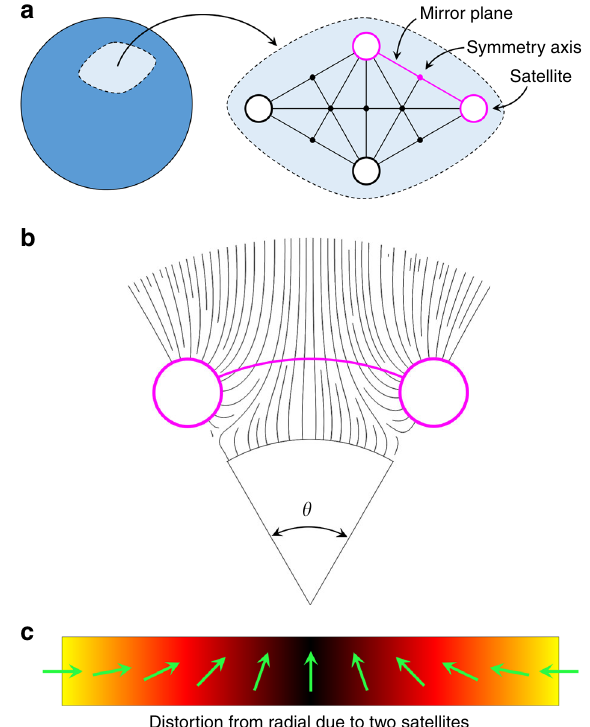
Fig. 2 Satellite distortion network. a Sub-domain of the spherical surface corresponding to the primary satellite orbit. Large un fi lled circles represent satellites, small fi lled circles represent symmetry axes of rotation with radial director pro fi les and solid lines represent unfolded mirror planes. The plane of highest disturbance (repeated in the structure) is highlighted in magenta. b A slice of the magenta plane from a , showing the director streamlines due to two satellites separated by a polar angle of θ . c Distortion of the director fi eld in the radial reference frame as a function of the polar angle between two neighboring satellites along their orbital path, magenta arc from b